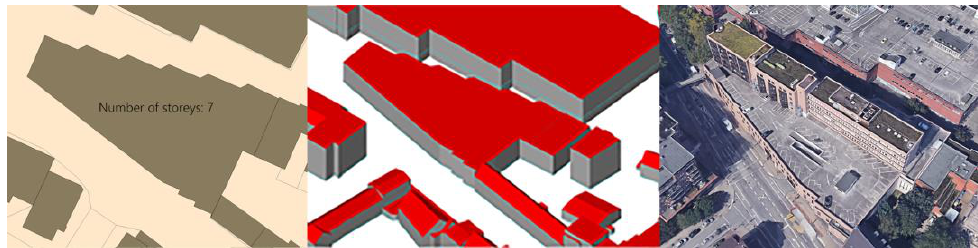
Fig. 1. False volume estimations. Left to right: ALKIS, 3D model (LoD2) and Google Earth.